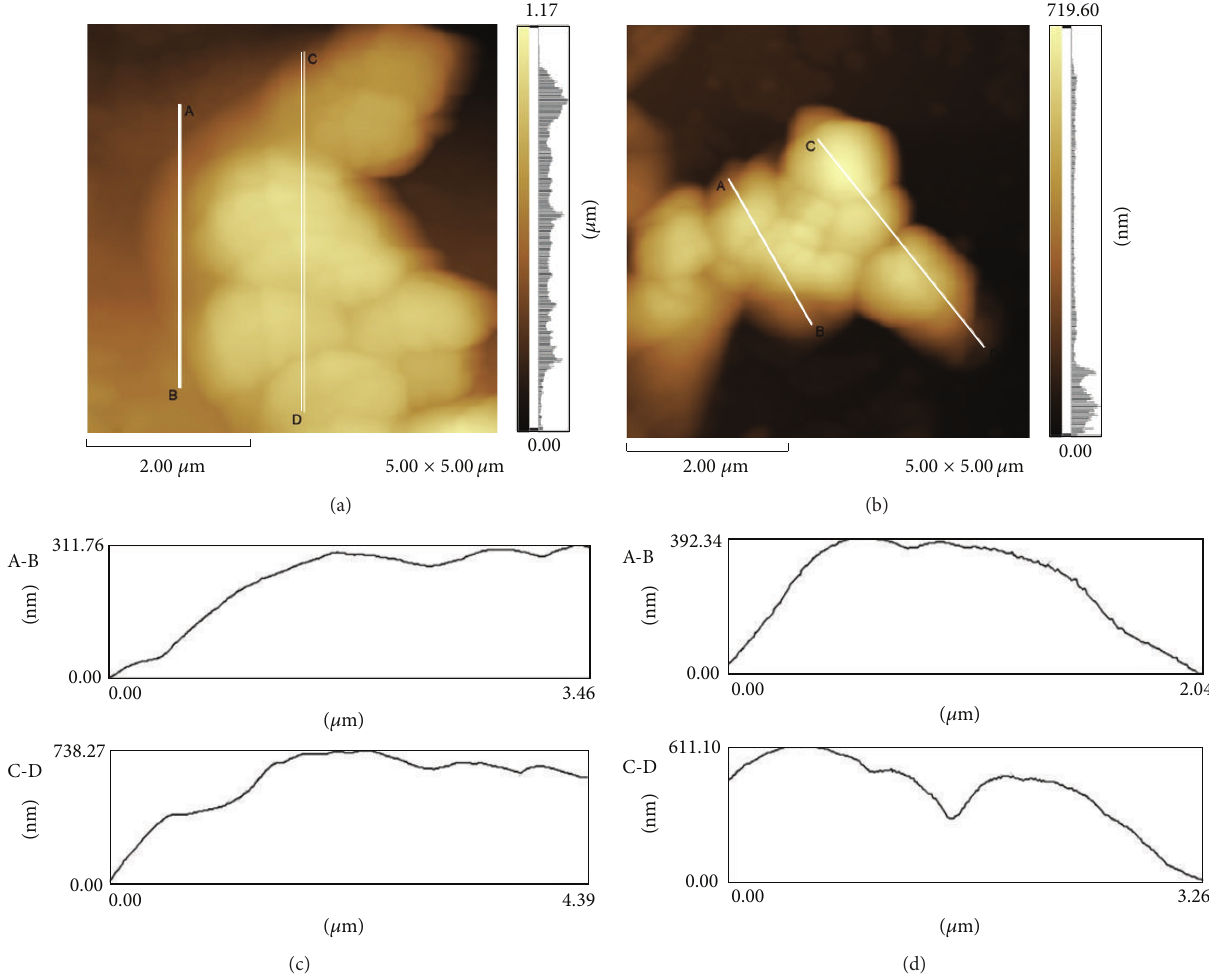
Figure 2: Atomic force microscopy of K. pneumoniae subsp. pneumoniae . Topographic profile of cell aggregates and biofilm on glass ((a) and (c)) and polyester ((b) and (d)). Plan view ((a) and (b)). Cell aggregate topographical profile along the lines A-B and C-D ((c) and